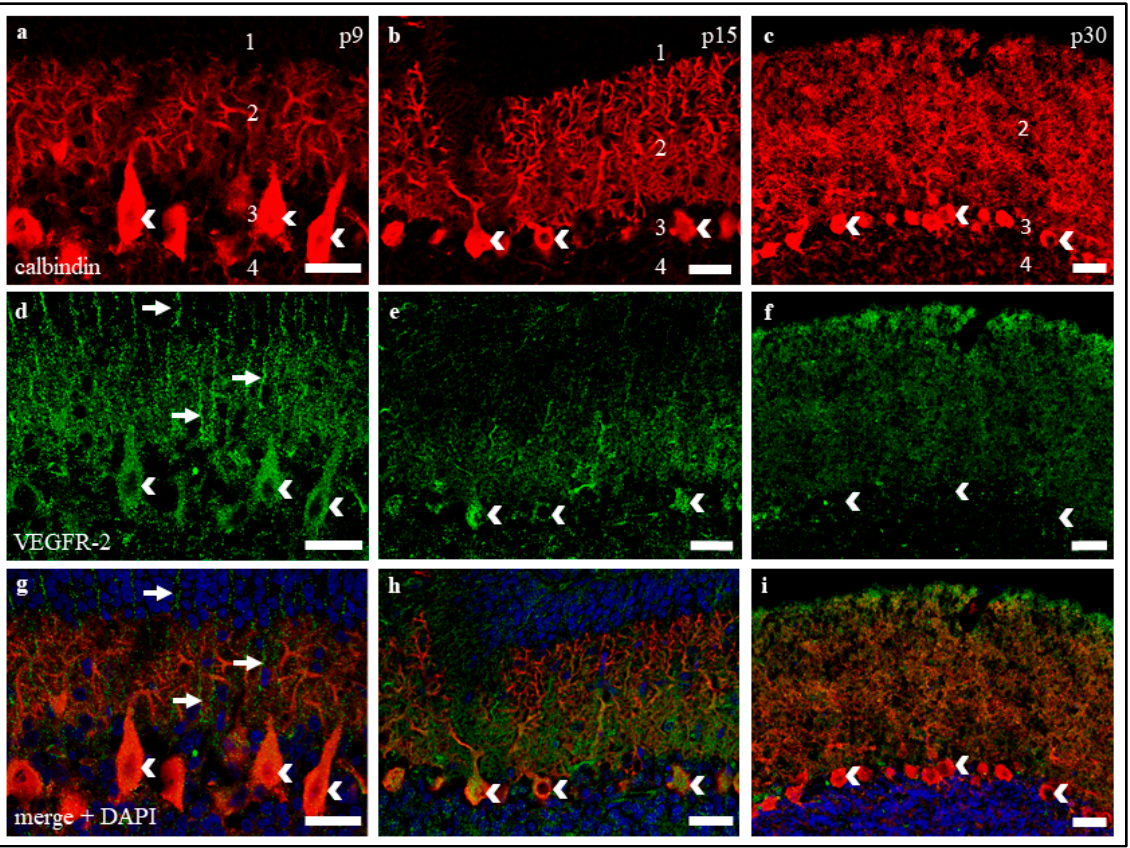
Figure 2. VEGFR-2 expression in cryosections of p9, p15, and p30 cerebella. ( a – i ) Immunostaining of calbindin positive PC (red), VEGFR-2 (green) and cell nuclei (blue) in cerebellar cryosections of rats at p9, p15, and p30. The images show that VEGFR-2 is localised in PC soma (white arrowheads) and dendrites. ( a , d , g ) At p9, VEGFR-2 could also be found in Bergmann glia fibres ascending to the external granular cell layer (eGCL) (white arrows). The same exposure settings were used for all exposures and no post-correction was applied. 1 = eGCL, 2 = molecular cell layer (MCL), 3 = Purkinje cell layer (PCL), 4 = GCL. Scale bars: ( a , d , g ) 50 µm; ( b , c , e , f , h , i ) 100 µm.